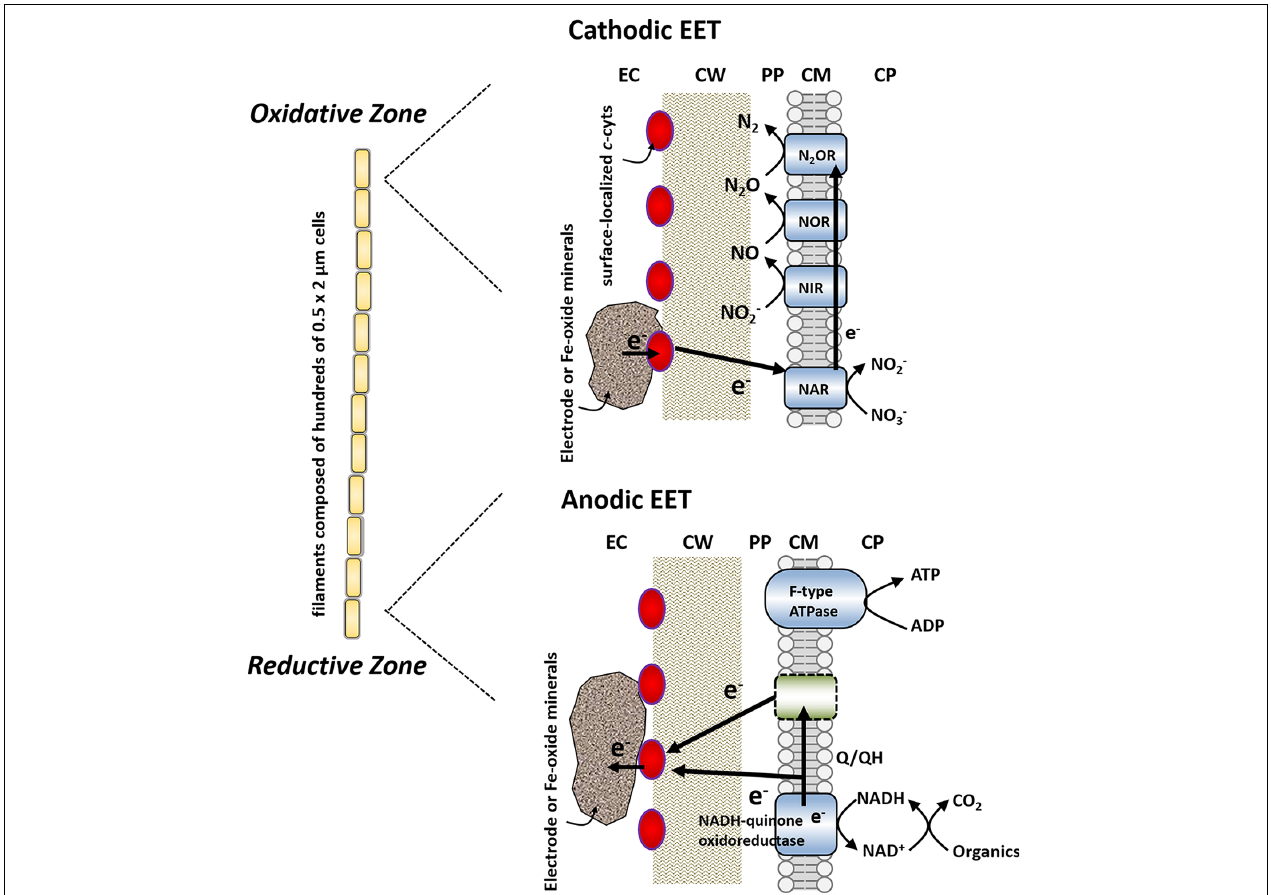
FIGURE 6 | Proposed model for bidirectional extracellular electron transfer by strain 110S. Cells in the oxidative zone uptake electrons from the surface-localized conduit ( c -cyts or conductive minerals) coupled with the half reaction of nitrate reduction. Simultaneously, cells localized in the reductive zone transfer electrons to the conduit coupled with the oxidative half reaction of organic compounds. Red ovals depict surface-localized c -cyts. EC, extracellular environment; CW, cell wall; PP, periplasm; CM, cellular membrane; CP, cytoplasm; NAR, nitrate reductase; NIR, nitrite reductase; NOR, nitric oxide reductase; N 2 OR, nitrous oxide reductase. Membrane-bound enzymes shown in blue (NAR, NIR, NOR, N 2 OR, NADH-quinone oxidoreductase, and F-type ATPase) are detected in the genome sequence. The location of nitrate reduction enzymes is modeled based on the situation with other monoderm (Gram positive) bacterium, Bacillus azotoformans (Suharti et al., 2004; Suharti and de Vries,